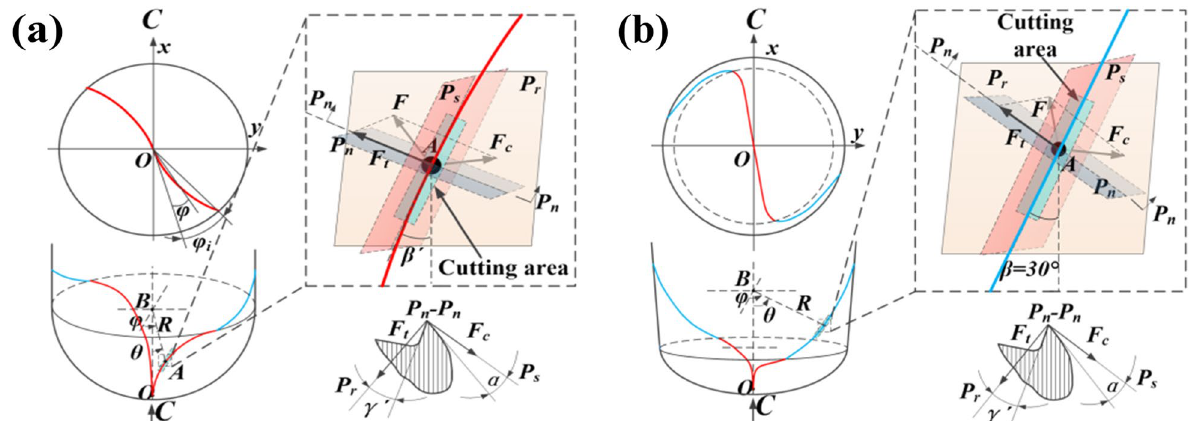
Figure 8 Milling force model diagram: a BEMC and b